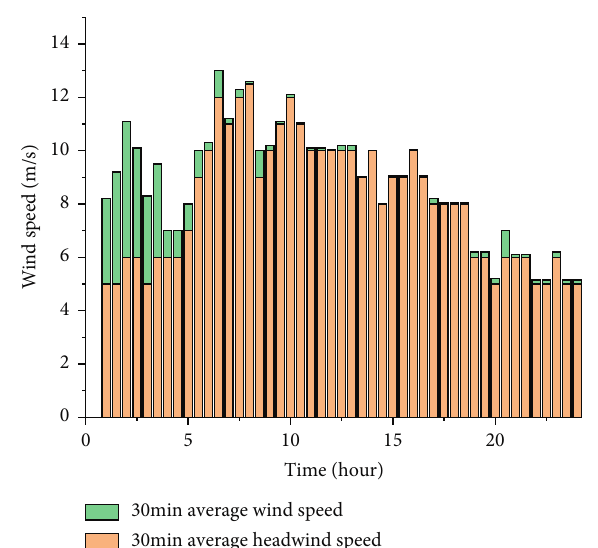
Figure 7: Within 30min average wind speed of Shanghai Pudong Airport on January 31, 2019. The green column is the average wind speed within 30 minutes, and the red column is the wind speed against the